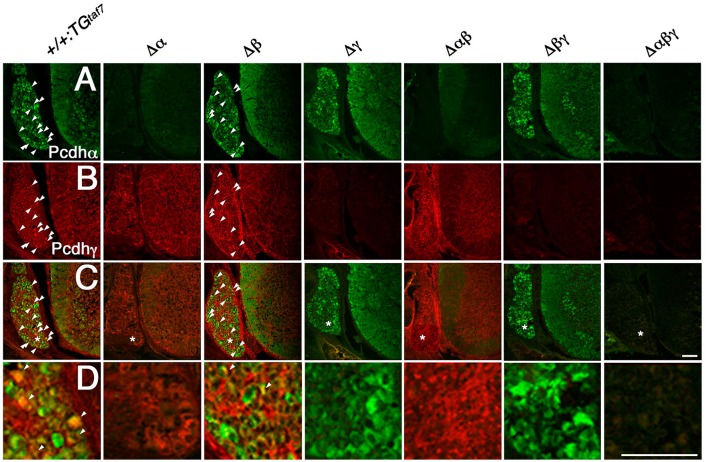
Immunohistochemistry in the spinal cord. (A–D) Pcdhα and Pcdhγ proteins were widely distributed in sections from the E16.5 cervical spinal cord. (A) Many DRG neurons were differentially stained by an anti-Pcdhα antibody. Moderate Pcdhα immunoreactivity was extensively detected throughout the ventral cord. In contrast, (B) Pcdhγ immunoreactivity was broader than that of Pcdhα, and was distributed in the DRG and spinal cord. (C) Double-staining with anti-Pcdhα and anti-Pcdhγ antibodies revealed that subpopulations of DRG sensory neurons co-expressed Pcdhα and Pcdhγ (arrowheads). (D) Magnified views of the regions (*) were shown. There was no Pcdhα or Pcdhγ immunoreactivity in the Δα and Δγ spinal cords, respectively, confirming that each deletion mutant was a complete null-mutant strain. Bars: 100 μm.